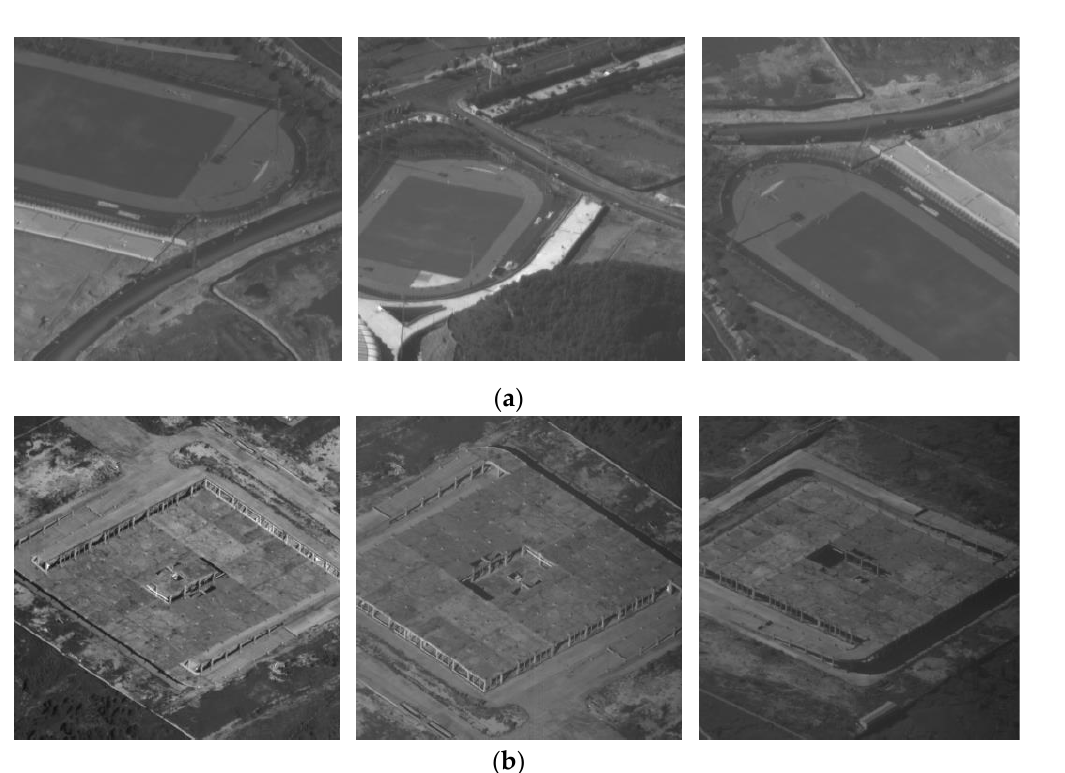
Figure 16. The remote sensing images obtained by the LRORS: ( a ) the remote sensing images of the target point G1; ( b ) the remote sensing images of the target point G2.